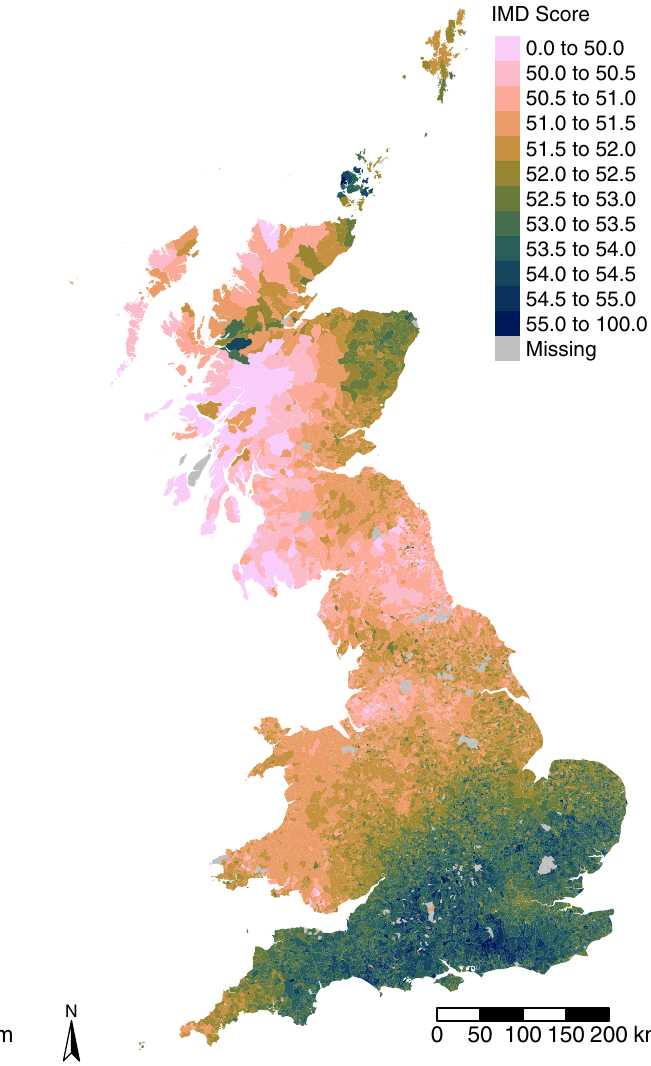
Fig. 3 Modelled Index of Multiple Deprivation (IMD) scores. 2016 modelled LSOA IMD percentile scores, calculated as the average ‘ family IMD scores ’ of all residents drawn from long-established family names. There is a distinctive pattern in which the southwest of England has on average a higher modelled IMD score than the rest of Great Britain.